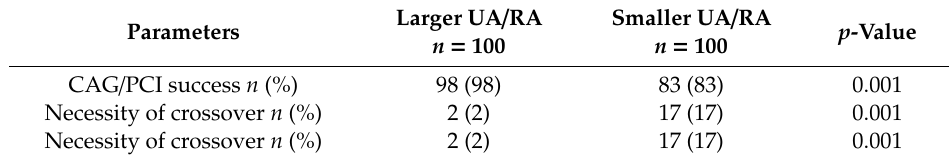
Table 4. Primary endpoint—e ffi cacy of vascular access in larger vs. smaller